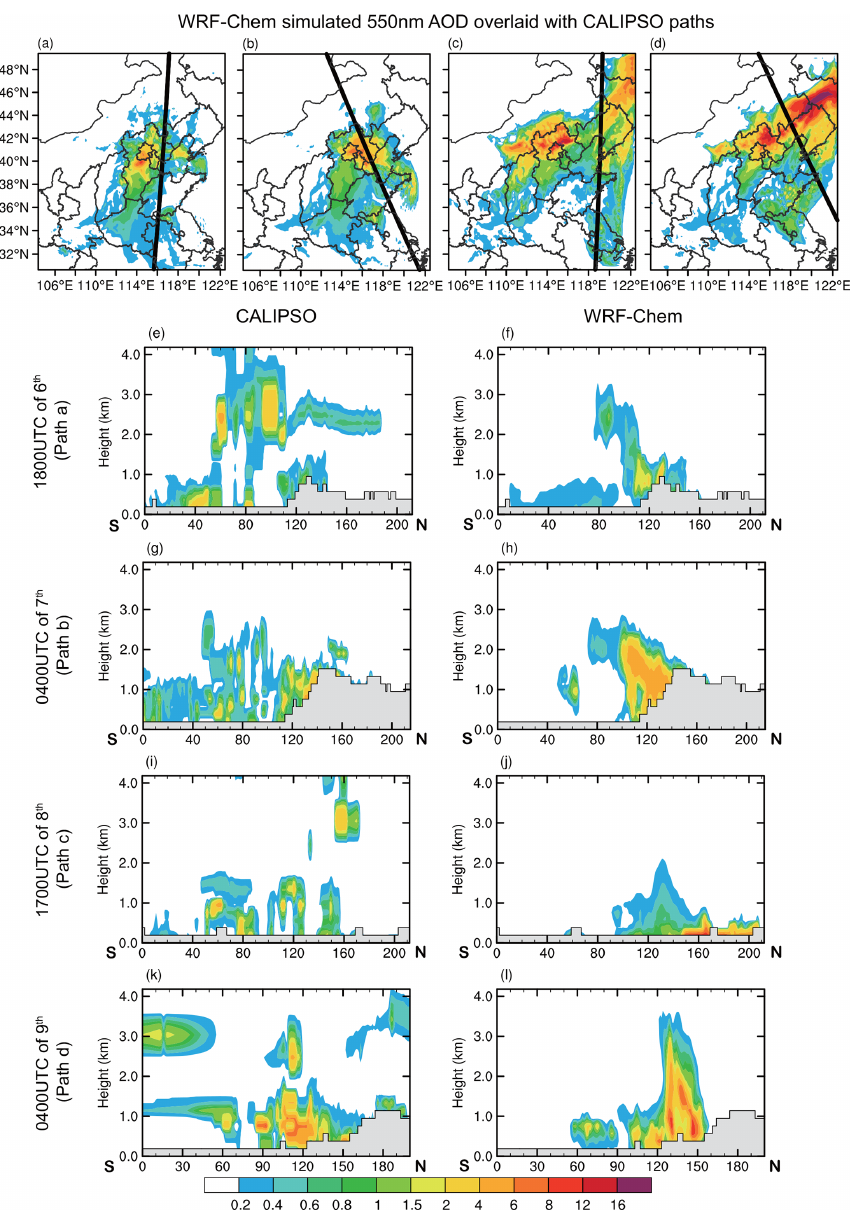
Figure 3. The WRF-Chem-simulated 550nm AOD (shadings) on (a) 18:00UTC on 6 December, (b) 04:00UTC on 7 December, (c) 17:00UTC on 8 December, (d) 04:00UTC on 9 December overlaid with CALIPSO paths (black thick solid). Panels (e–l) denote the corresponding vertical distributions of aerosol extinction coefficient at 550nm from (e, g, i, k) CALIPSO and (f, h, j, l) model simulations. Gray areas in (e–l) denote the